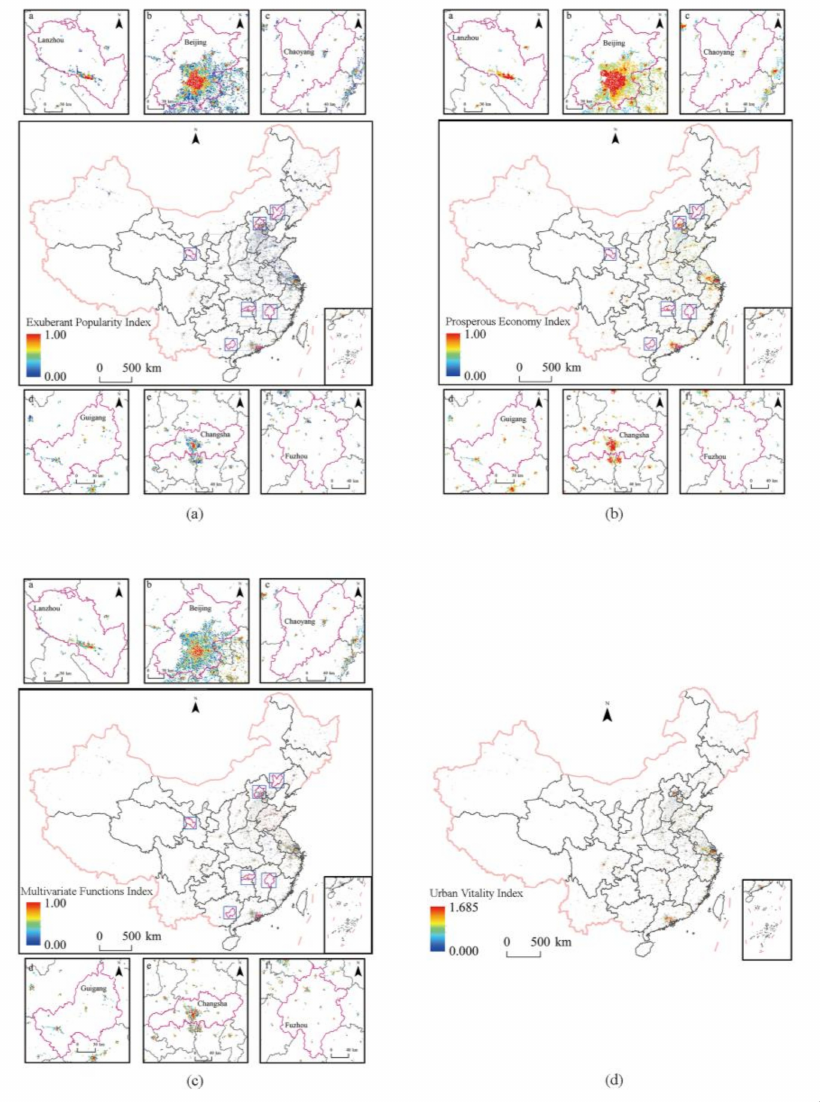
Figure 3. Spatial distribution of UVI of urban areas in China at grid scale: ( a ) Exuberant Popularity Index, ( b ) Prosperous Economy Index, ( c ) Multivariate Functions Index, and ( d ) Urban Vitality Index. a: Lanzhou City, b: Beijing City, c: Chaoyang City, d: Guigang City, e: Changsha City, f: Fuzhou